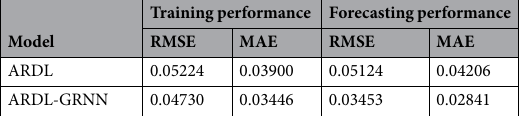
Table 4. Comparison of the modeling and forecasting performance of ARDL and ARDL-GRNN